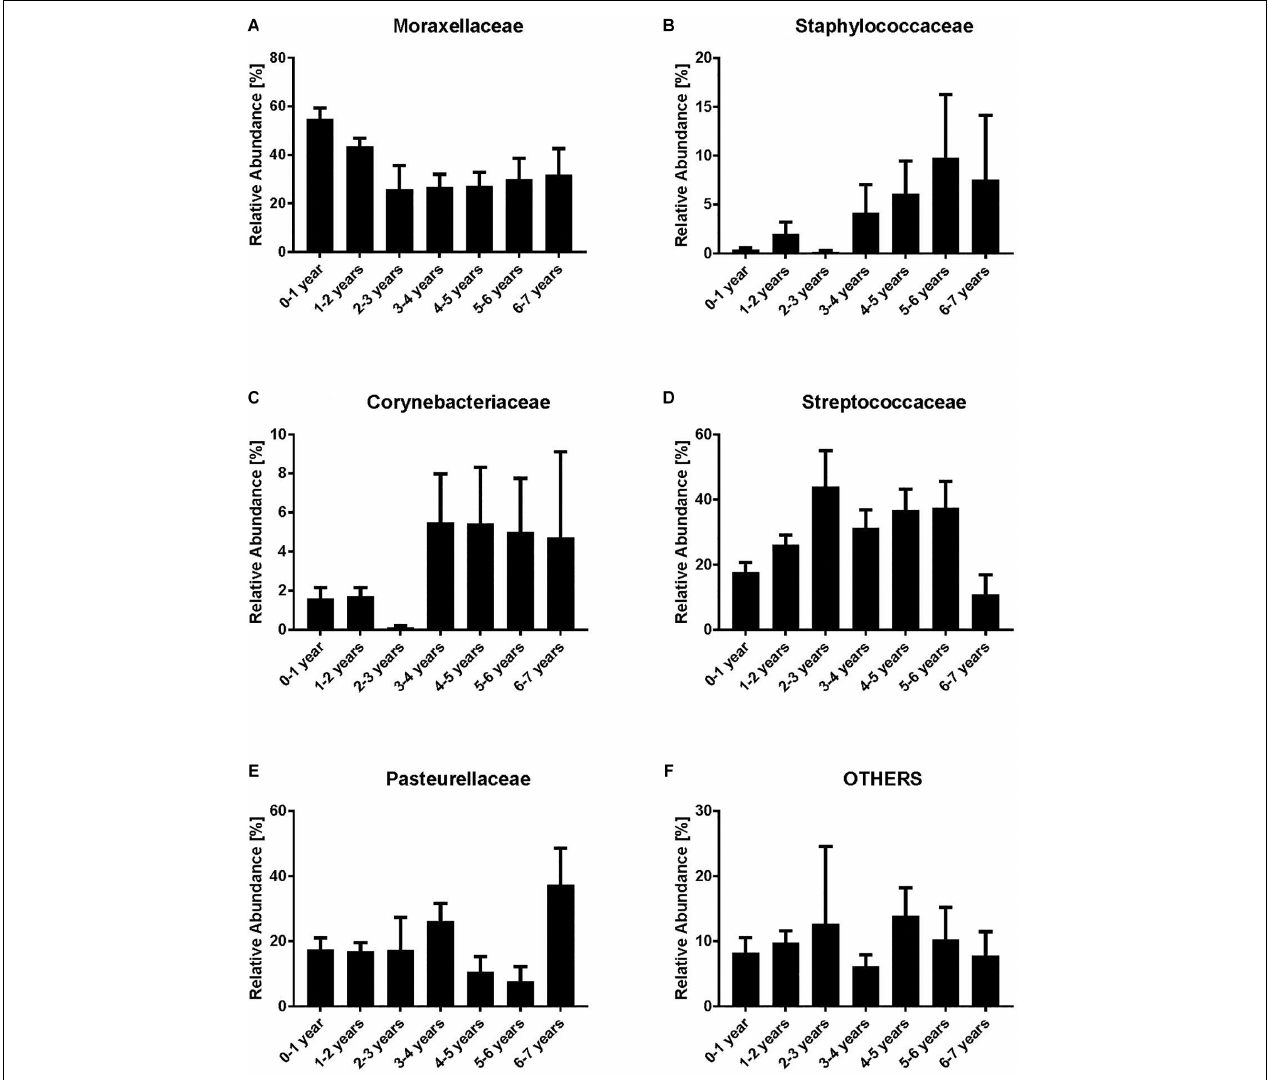
FIGURE 1 | Relative abundances of bacterial families [Moraxellaceae (A) , Staphylococcaceae (B) , Corynebacteriaceae (C) , Streptococcaceae (D) , Pasteurellaceae (E) and Others (F) ]. Indicated are the most abundant bacterial families while all the remaining are grouped as “others.” Bars represent mean values according to the age of the children with acute otitis media on the x -axis (in years). Moraxellaceae is the most abundant family within the younger age groups, whereas in older age groups Corynebacteriaceae and Staphylococcaceae are most